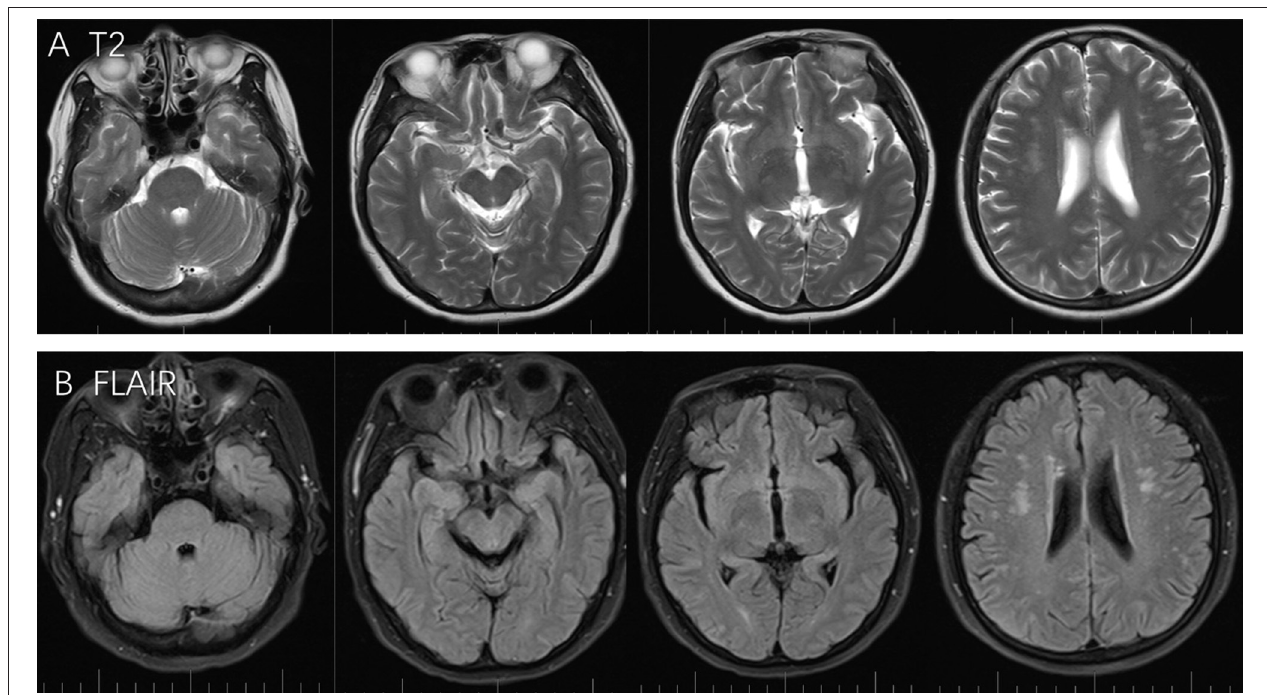
FIGURE 2 | T2 and Flair scans showed full regression from last attack, while no specific lesion was observed around the pons, cerebellum, frontal lobe, parietal lobe, and occipital lobe (A,B)